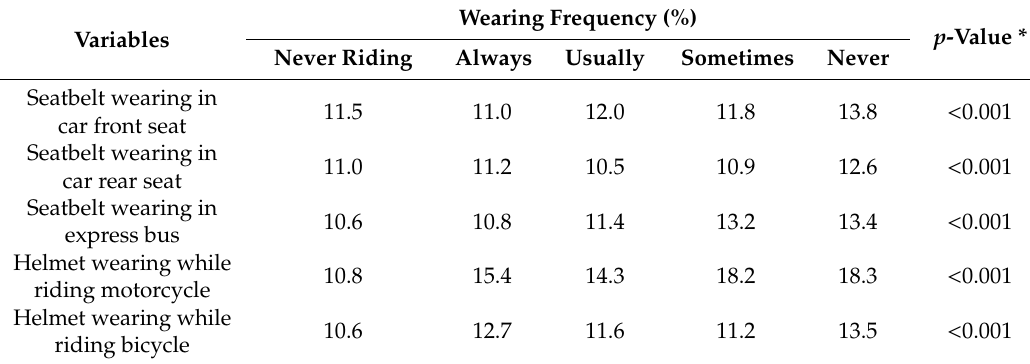
Table 3. Tooth fracture experience in the past 12 months by seatbelt or helmet wearing. Variables